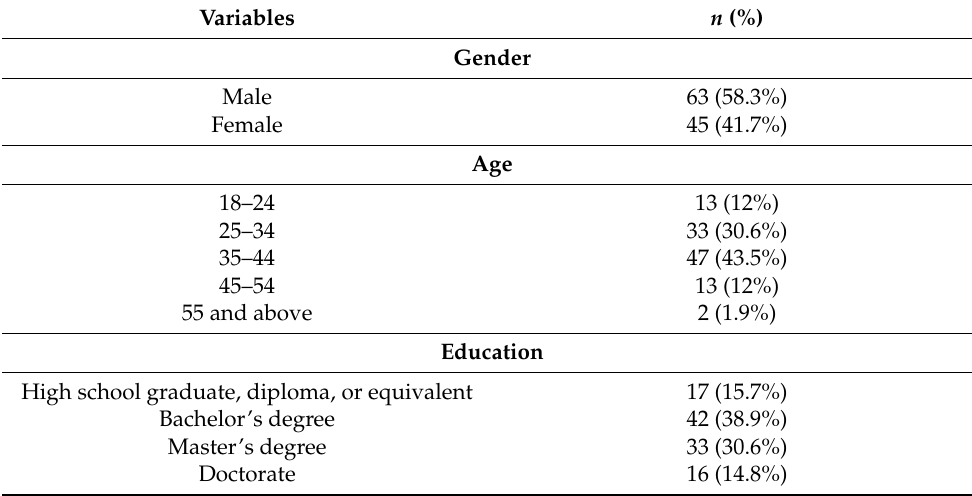
Table 1. Frequency distribution of demographic variables.